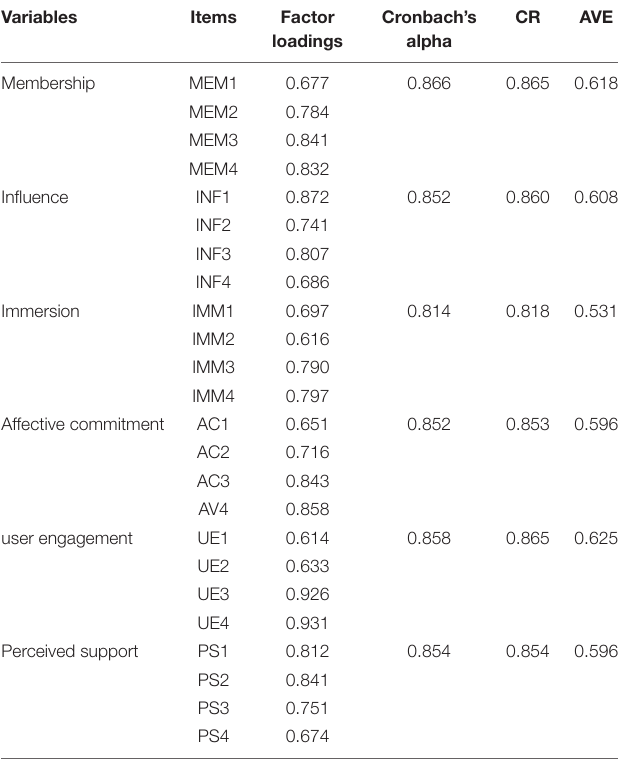
TABLE 3 | Confirmatory factor analysis.